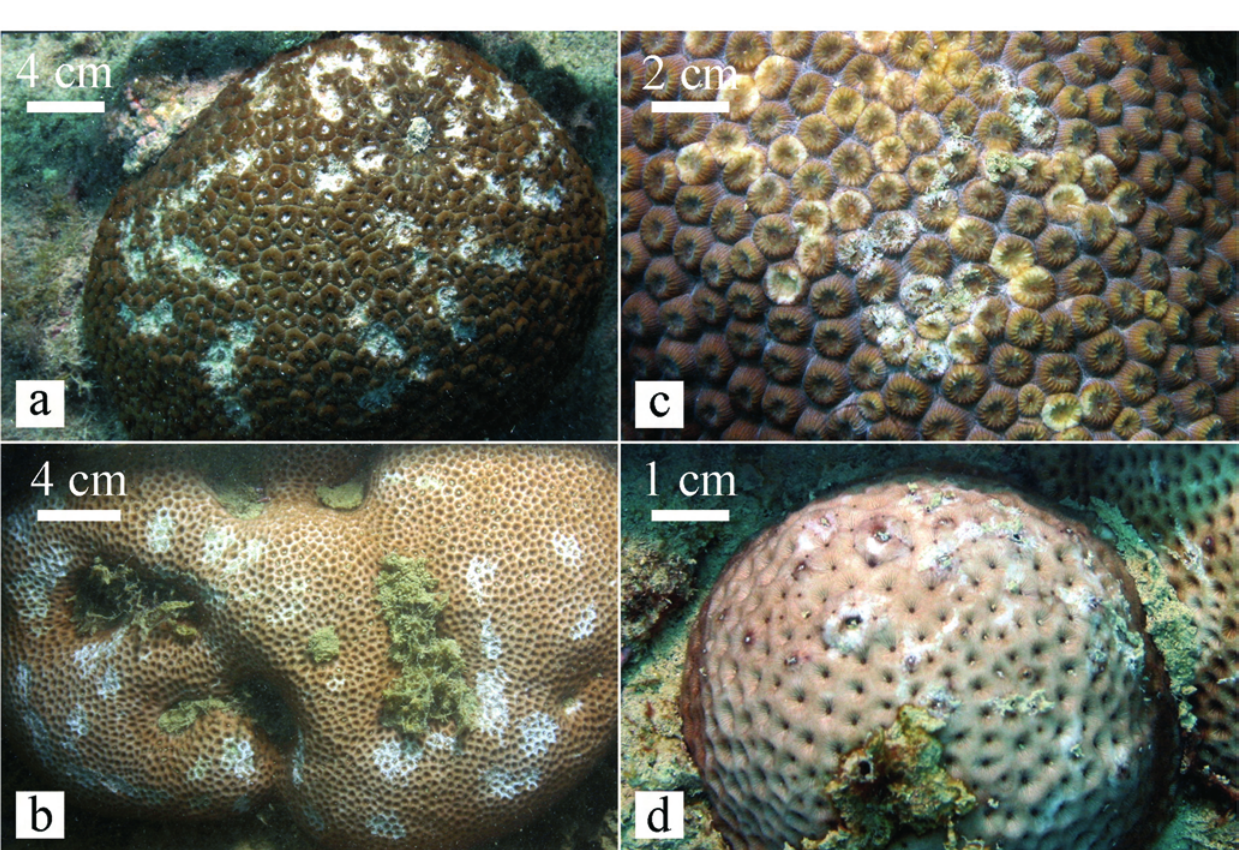
Fig. 4. Bite scars of Sparisoma amplum (a and b) and Scarus trispinosus (c and d) on the corals Montastrea cavernosa (top) and Siderastrea spp. (bottom).